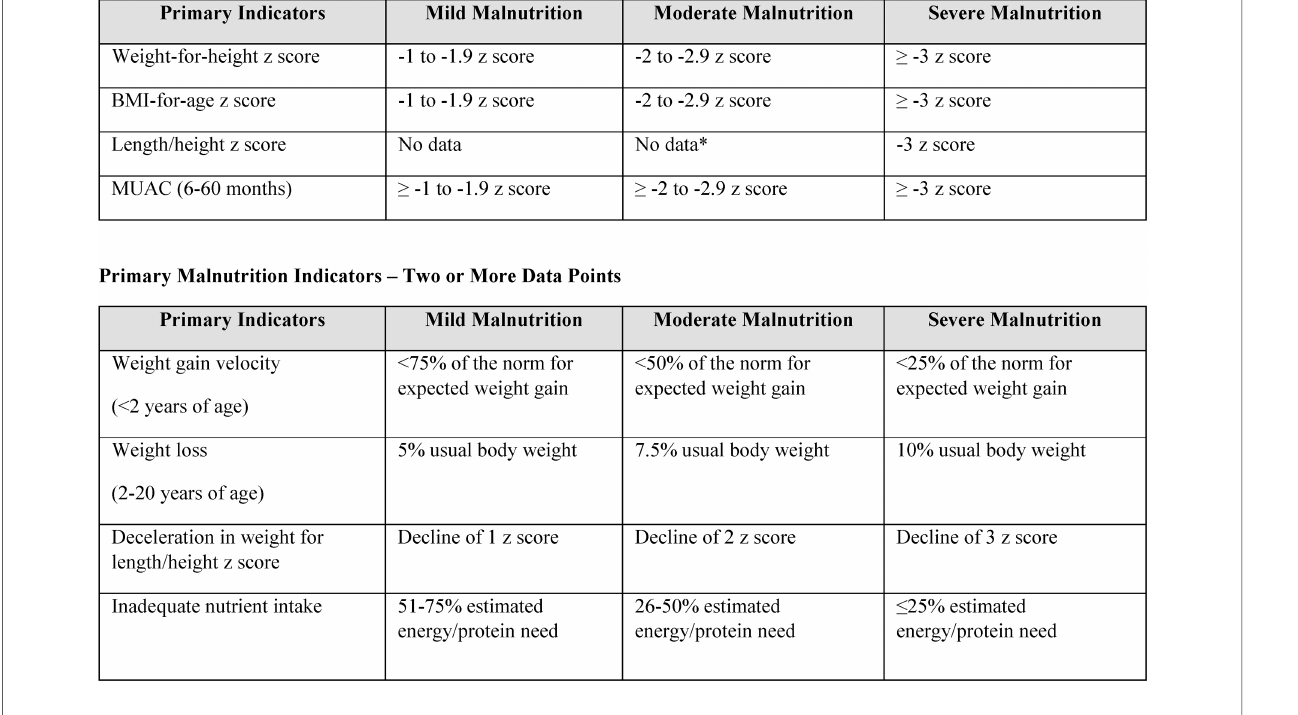
FIGURE 1 Texas children ’ s hospital pediatric malnutrition tool (8).